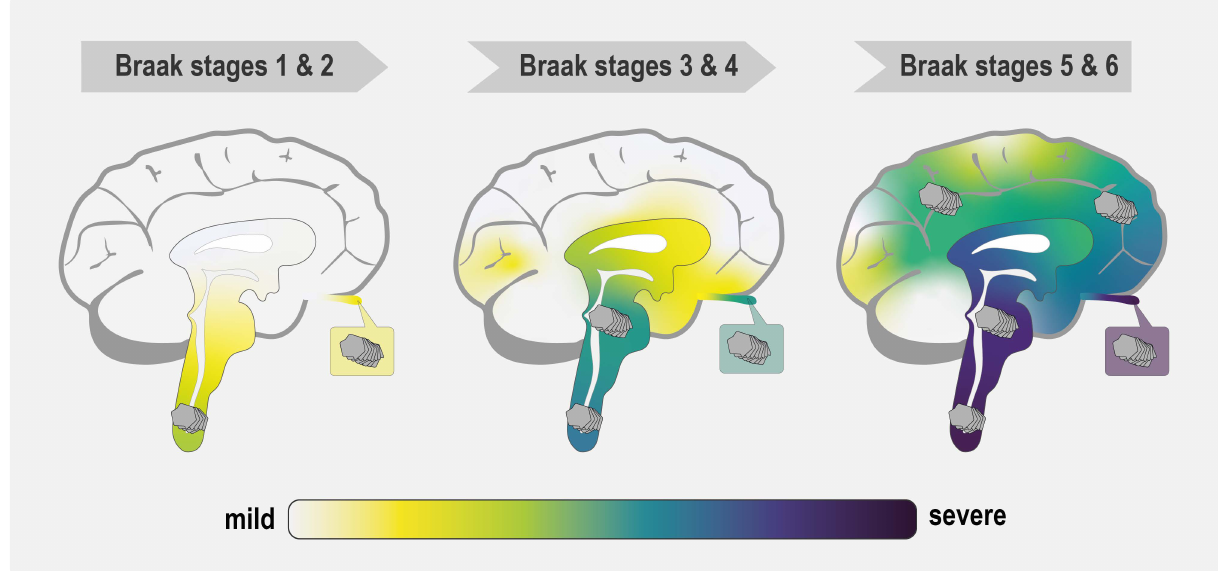
Figure 2. Schematic representation of α -Syn inclusion distribution in PD according to Braak staging. Brainstem and cortical Lewy bodies first appear in the lower brainstem and olfactory bulb of PD patients in Braak stages 1 and 2. In stages 3 and 4, Lewy bodies progressively accumulate in higher brainstem regions and in indicated cortex regions. Finally, PD patients in Braak stages 5 and 6 show accumulation of pathological α -Syn deposits throughout the cortex and brainstem. In the cartoon, the colored areas correspond to regions with α -Syn inclusions and neuronal loss, the intensity of which is indicated by the hue (yellow/mild →